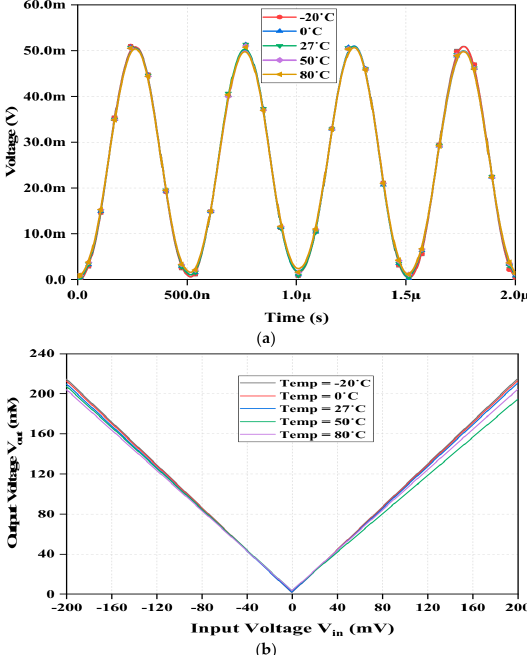
Figure 10. Temperature analysis of the proposed rectifier circuit ( a ) Transient response ( b ) Input and output DC